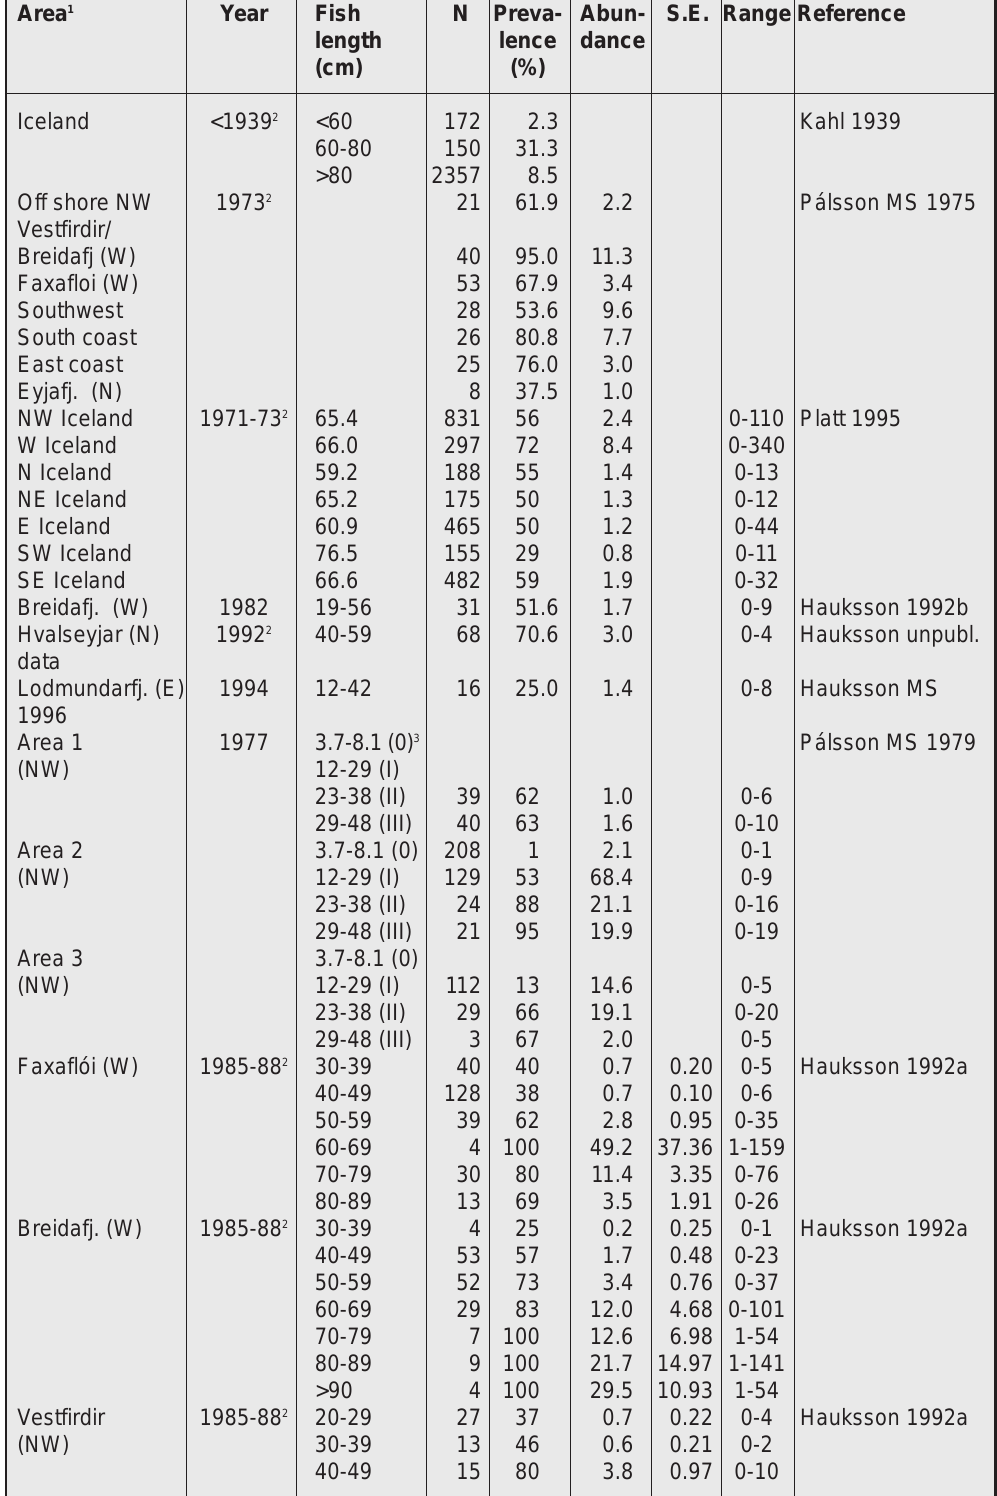
Table 1 Historical information of prevalence and abundance of sealworm ( Pseudoterranova decipiens ) in cod ( Gadus morhua ) fillets in Icelandic